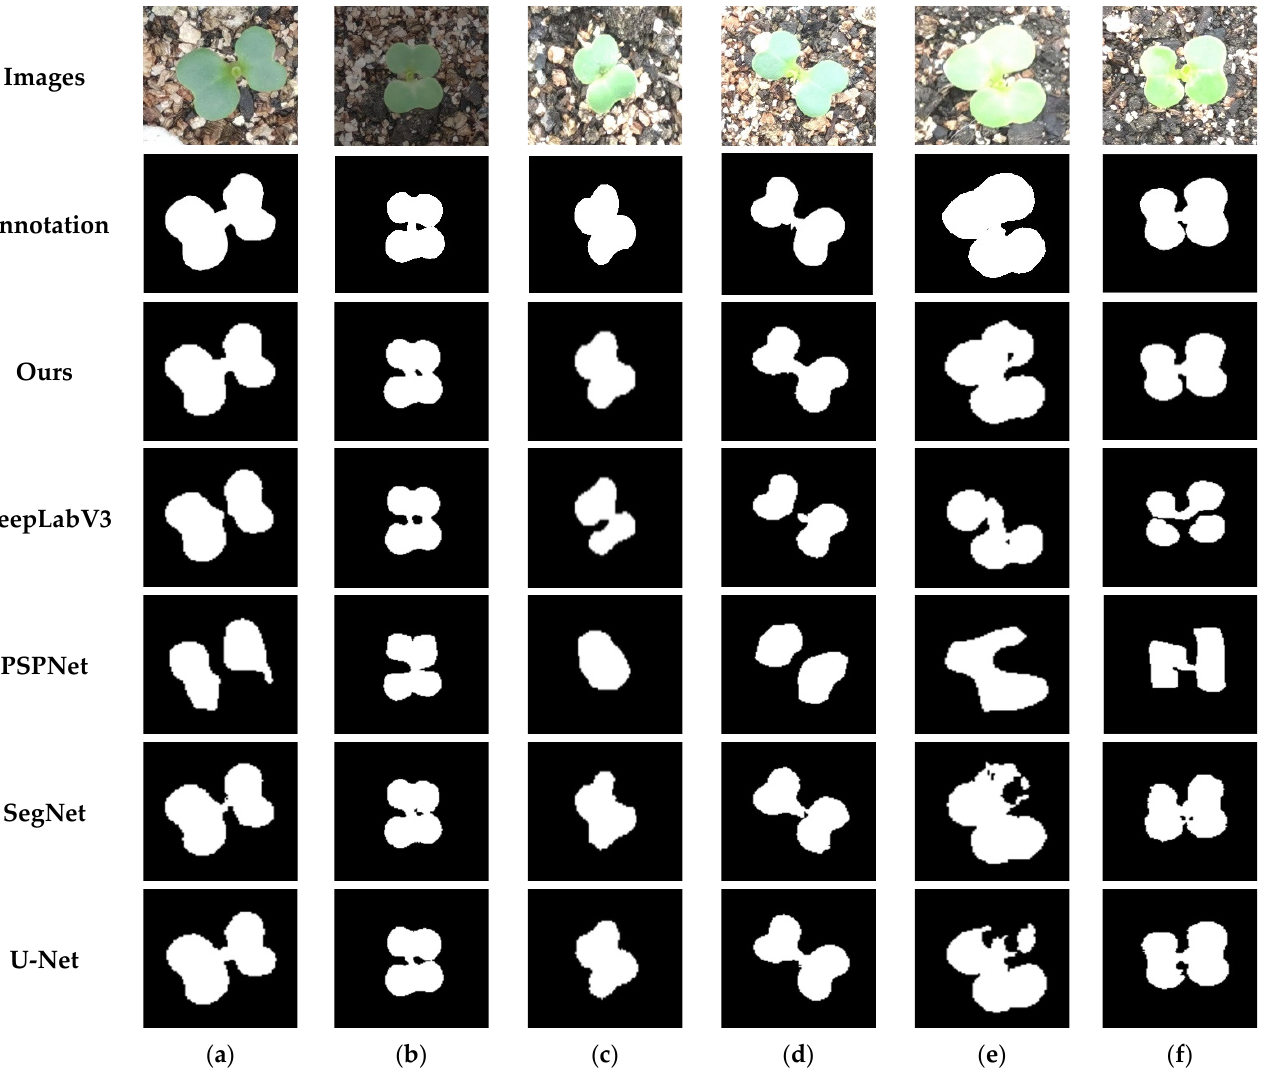
Figure 7. Segmentation results of different models; the images ( a – f ) are randomly selected from the test set.